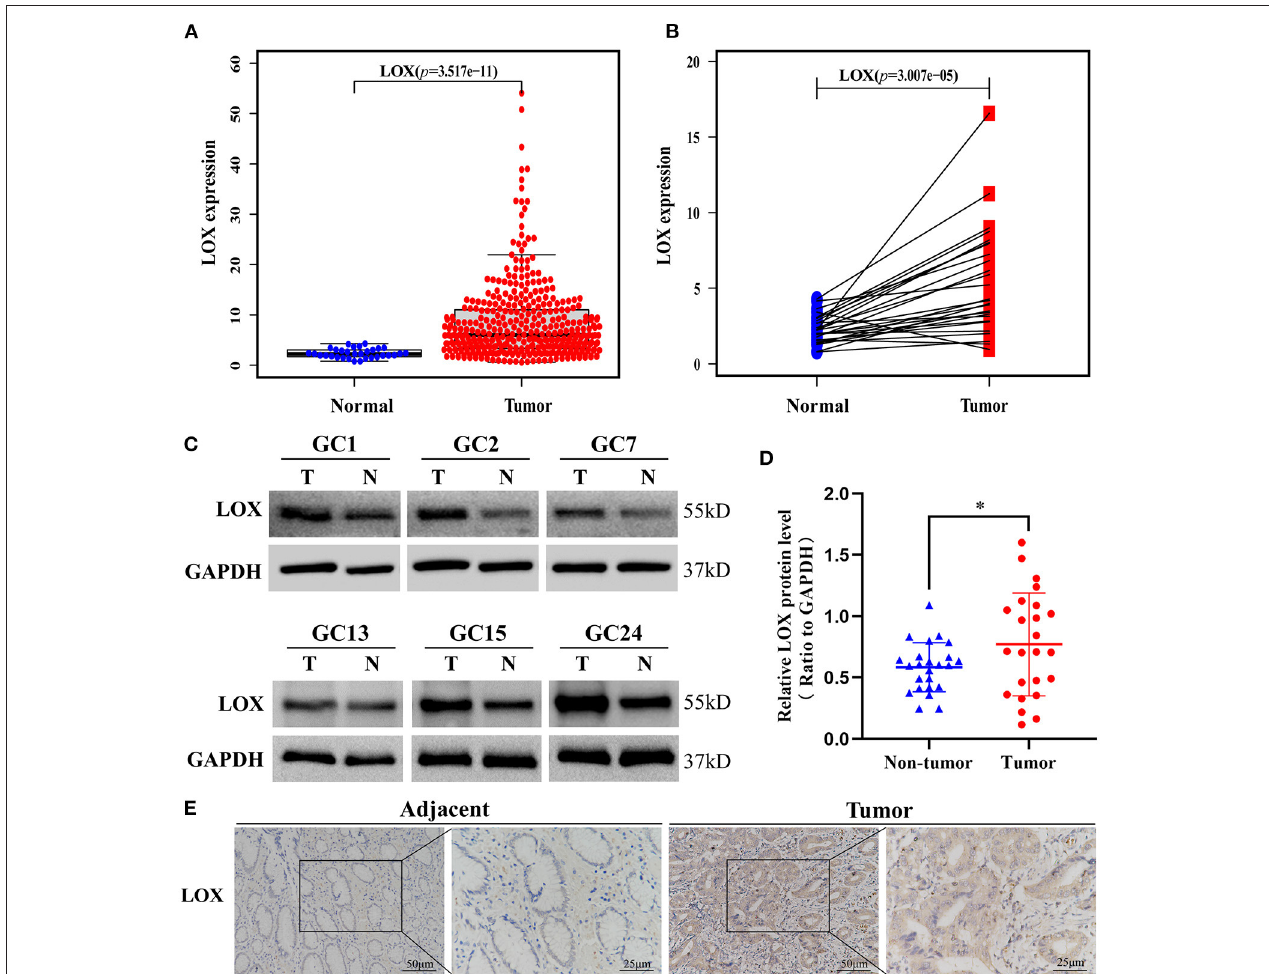
FIGURE 1 | The expression of LOX in GC tissues was significantly higher than that of neighboring normal tissues based on TCGA data. (A) The expression of LOX in GC tissues is significantly higher than in normal tissues ( p = 3.517 × 10 − 11 ). (B) The expression of LOX in GC tissues was significantly higher than that of 27 pairs of non-cancerous adjacent tissues ( p = 3.007 × 10 − 5 ). (Wilcoxon rank-sum test). (C,D) The protein expression levels of LOX in GC tissues and matched non-tumor tissues were evaluated by Western blot ( p = 0.0189; n = 24; T, tumor; NT, non-tumor). (E) LOX representative IHC stained images in GC tissue and adjacent tissues ( n = 40; magnification: left, 200 × ; right, 400 × ). TCGA, The Cancer Genome Atlas. * p <